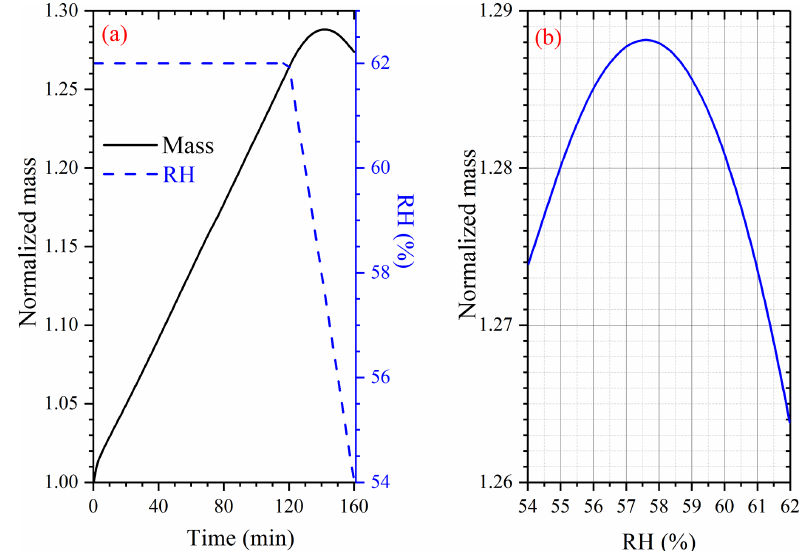
Figure 2. Typical experimental data in determination of DRH at a given temperature (NaBr at 25 ◦ C as an example) using Q5000SA by linearly decreasing RH. (a) Change of normalized sample mass (solid curve, left y axis) and RH (dashed curve, right y axis) as a function of time. (b) Change of normalized sample mass as a function of RH when RH decreased linearly from 62 to 54%.